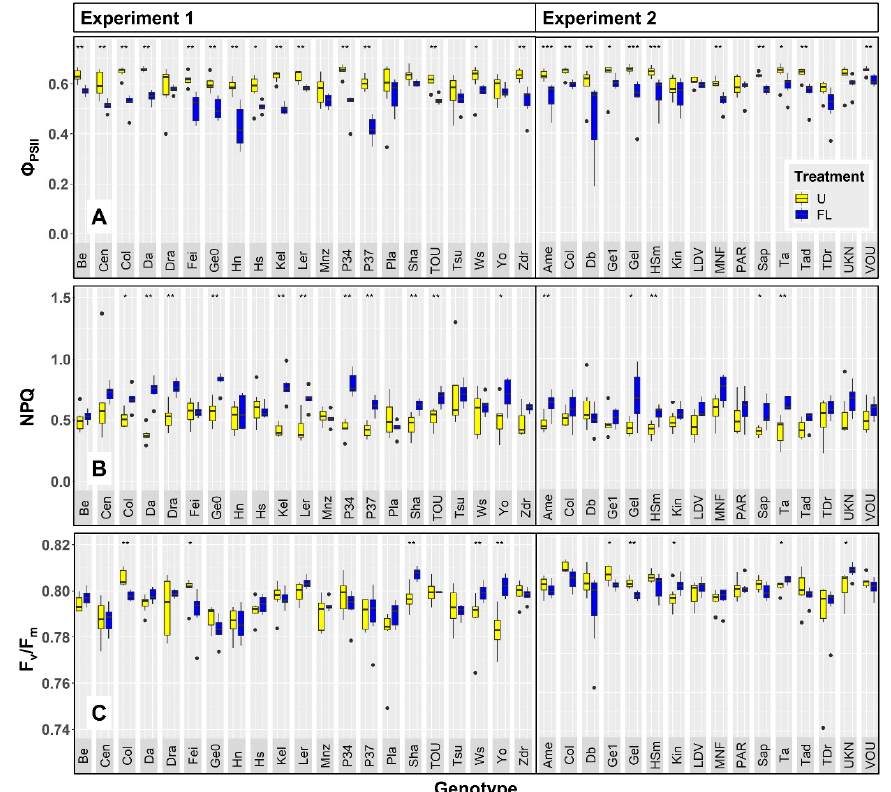
Figure 1. Chlorophyll a fluorescence analysis of 36 Arabidopsis accessions acclimated to uniform (U; yellow boxes) and fluctuating light intensities (FL; blue boxes), grown in two different experiments. ( A ) photosystem II operating efficiency ( Φ PSII ), ( B ) non-photochemical quenching (NPQ), and ( C )